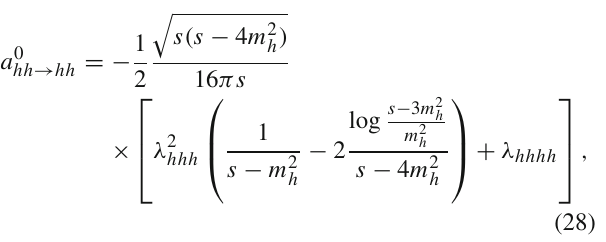
The J = 0 partial wave is found to